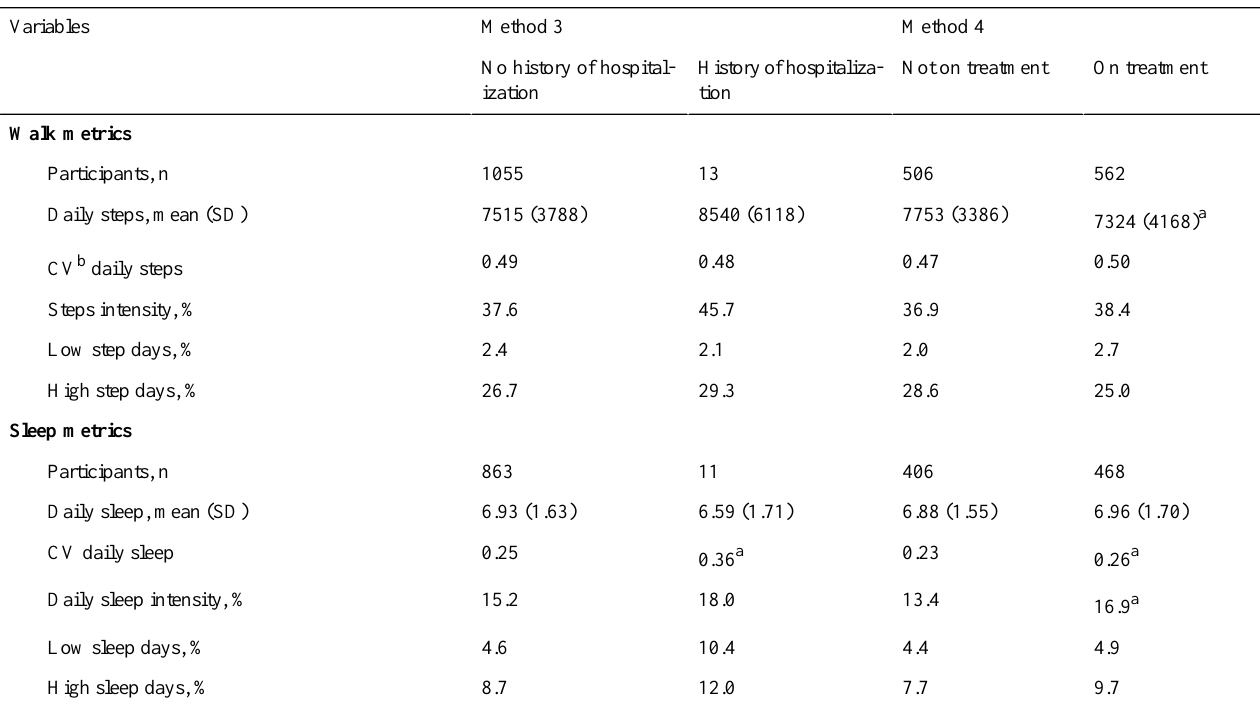
Table 6. Behavioral variables by classification method (Methods 3 and